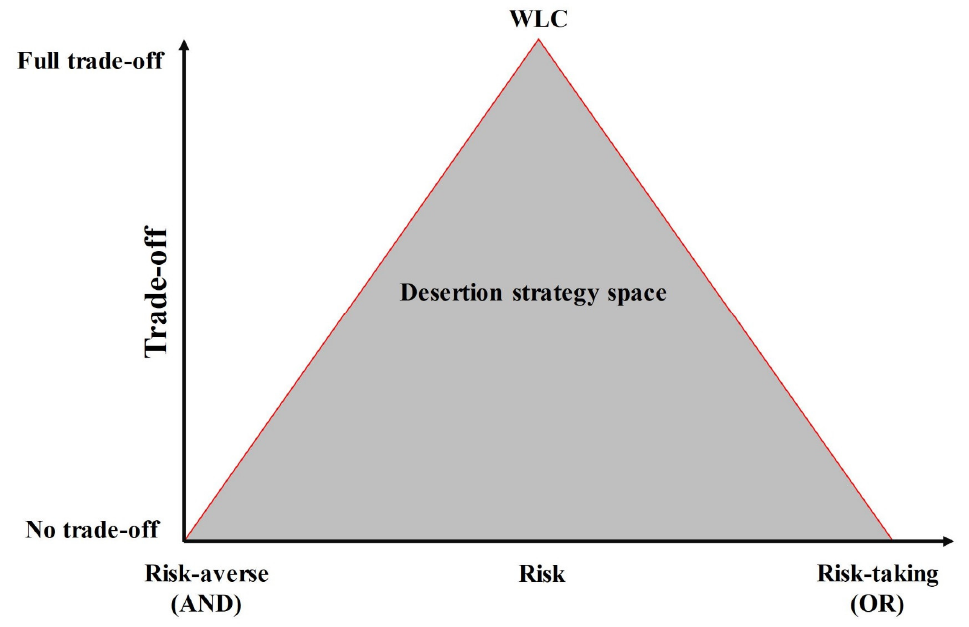
Figure 3. Decision strategy space with OWA operator (different risk conditions).